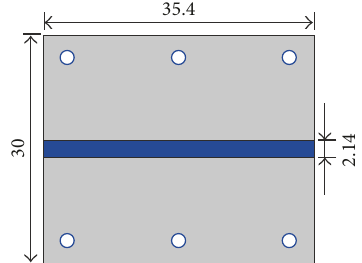
Figure 2: The structure of the thru standard.